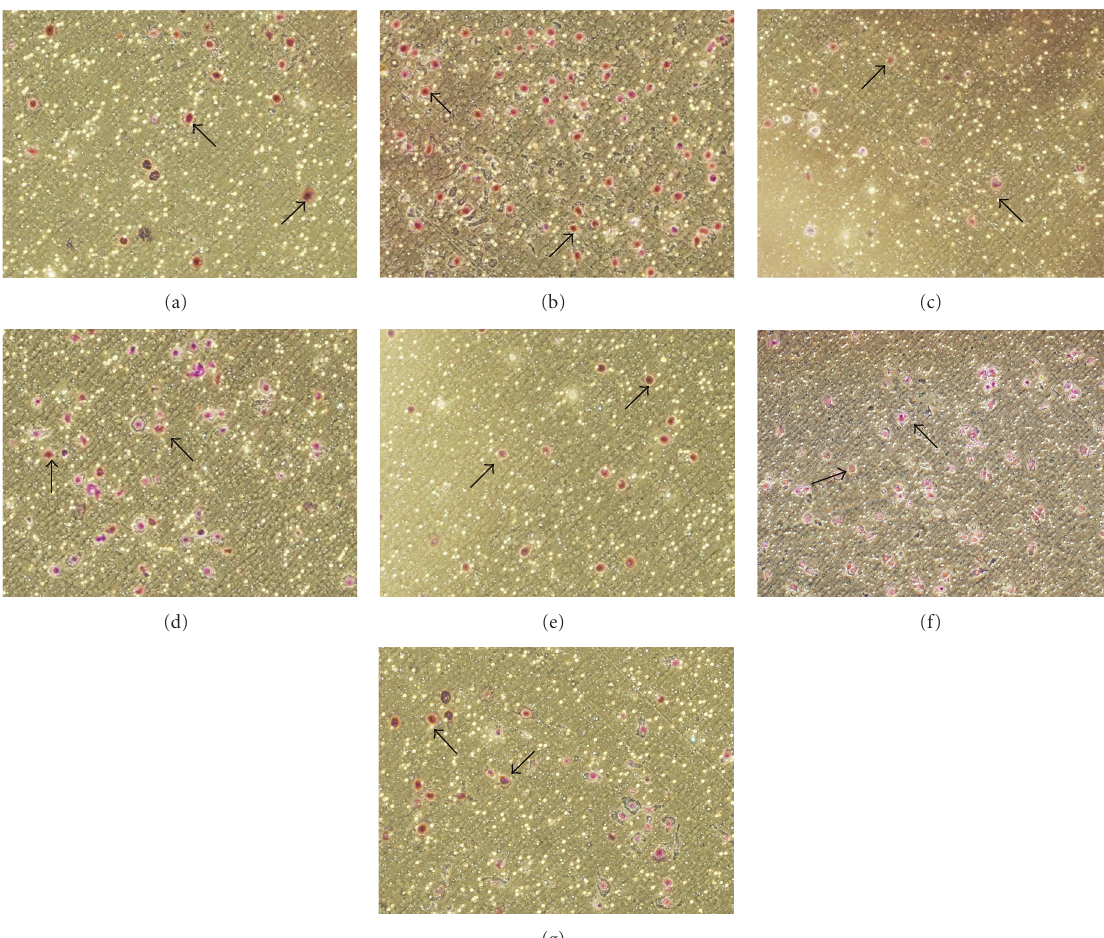
Figure 3: Cell motility assay: microscopic examination of cells (red dots by staining) migrated from the upper side to the lower side of the collagen-coated membrane (Olympus IX 71 microscope). Representative cells were indicated by arrow heads. (a) HepG2 cells transfected by Wild-type Rac1; (b) HepG2 cells transfected with Rac1 G12V ; (c) HepG2 cells transfected by Rac1 T17N ; (d) HepG2 cells transfected with Wild-type Rac1 and Wild-type HBV genome; (e) HepG2 cells transfected with Rac1 wt and P-A mutant HBV genome; (f) HepG2